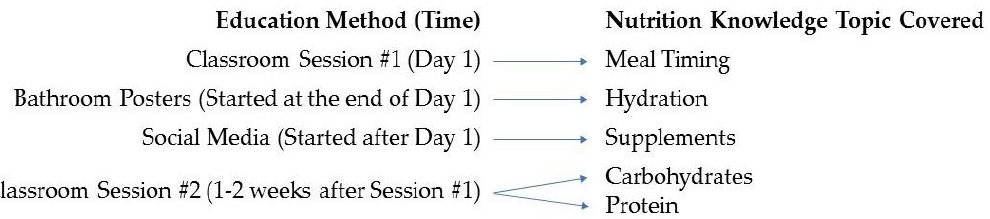
Figure 2. Nutrition education sessions according to the nutrition intervention technique.